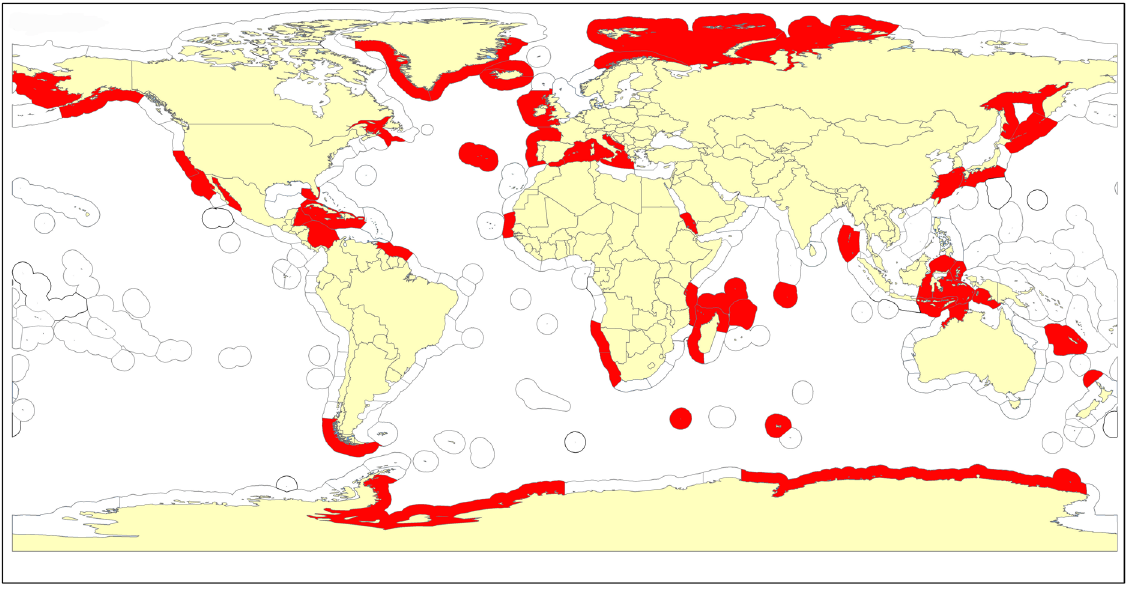
Fig. 3. Distribution of Haliclona ( Flagellia ) subgen. nov. in the marine ecoregions of the world (MEOWs, cf. Spalding et al . 2007), marked in red, depicting where one or more records assignable to Haliclona ( Flagellia ) subgen. nov. are known to date. Map courtesy of World Wildlife Fund